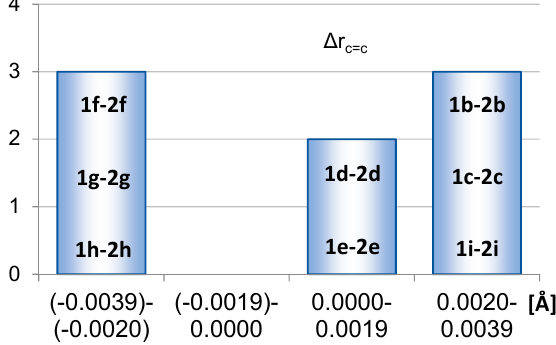
Figure 4. Distribution of ∆ r c=c = [r c=c ( 1a ) − r c=c ( 2a )] − [r c=c ( 1x ) − r c=c ( 2x )] values calculated at PBE0/6-31G(d) level, with x = b to i .